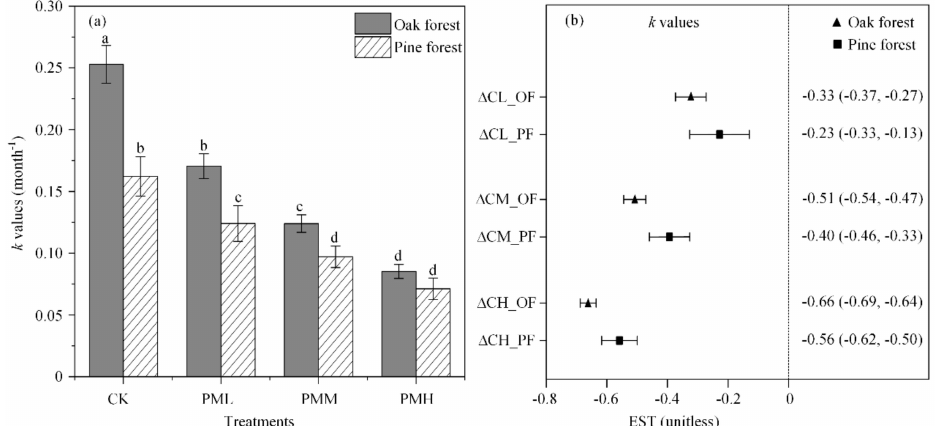
Figure 2. E ff ects of WSII–PM 2.5 exposure on the decomposition rates of oak and pine leaf litter. ( a ) Decomposition rates (mean k value, month − 1 ) of the two leaf litters during the six-month decomposition. Di ff erent lowercase letters above bars indicate significant di ff erences at p < 0.05. Error bars indicate standard deviation (SD, n = 4). ( b ) The relative di ff erences of leaf litter decomposition rates ( k ) between contrasting treatments, which are referred to as the e ff ect size of ∆ treatments (EST) on decomposition rate. The ∆ CL_OF, ∆ CM_OF, and ∆ CH_OF are the ESTs of CK relative to PML, PMM, and PMH on the oak forest. Similarly, the ∆ CL_PF, ∆ CM_PF, and ∆ CH_PF are the ESTs of CK relative to PML, PMM, and PMH on the pine forest. The means of EST and the 95% bootstrapping confidence intervals are shown. Positive ESTs indicate that decomposition is promoted by WSII–PM 2.5 , and negative ESTs indicate that decomposition is inhibited by WSII–PM 2.5 . The closer the EST is to 0, the smaller the e ff ect of WSII–PM 2.5 . Intervals non-crossed with the vertical zero dashed line indicate a significant e ff